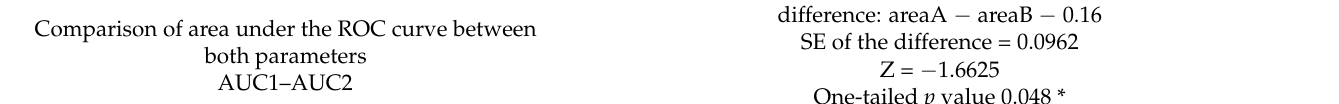
Comparison of area under the ROC curve between both parameters